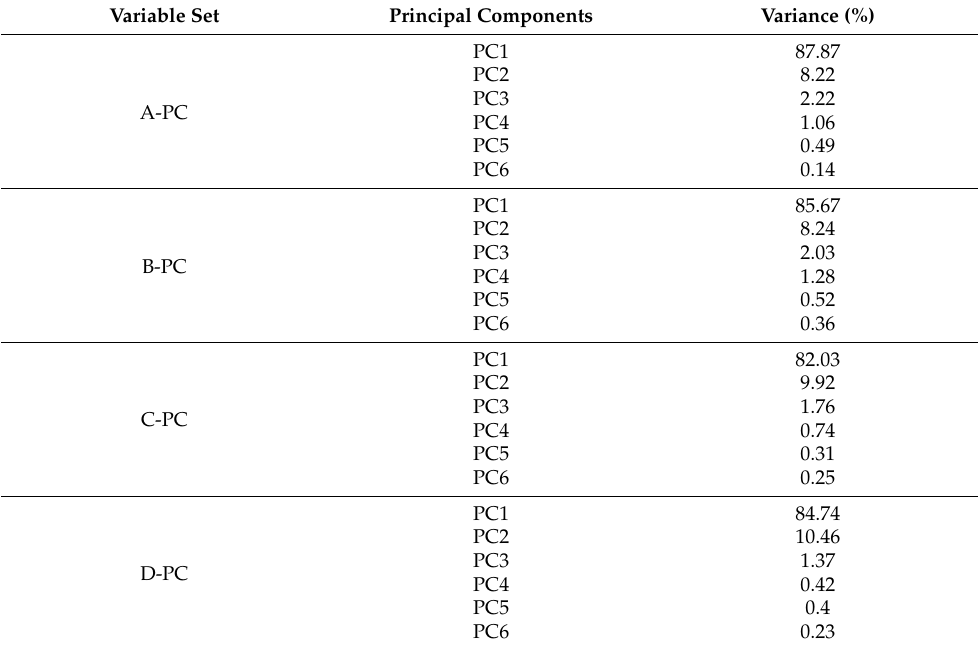
Table A4. Percentage of information contained in the first six components of the principal component analysis (PCA) of different sets of variables.